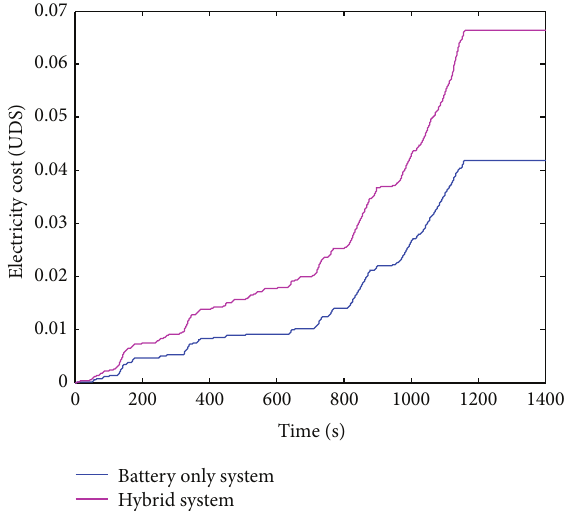
Figure 41: Comparison of the electricity cost based on NEDC driving